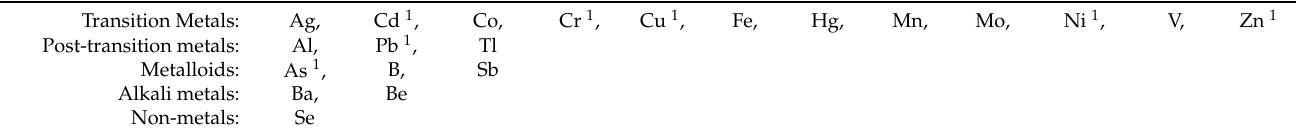
Table 1. The list of 21 inorganic elements that are commonly regarded as PTEs in environmental studies